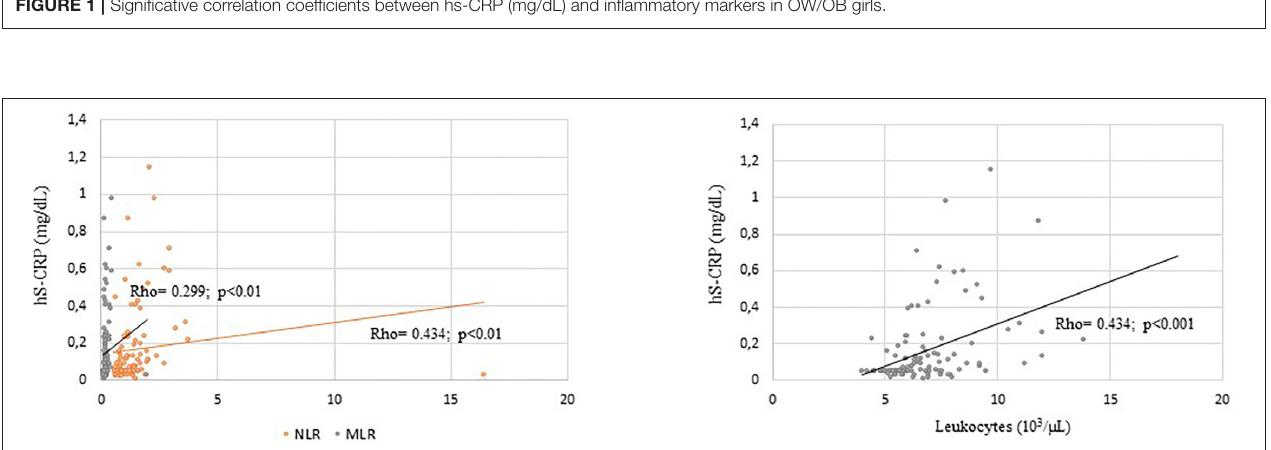
FIGURE 1 | Significative correlation coefficients between hs-CRP (mg/dL) and inflammatory markers in OW/OB girls.